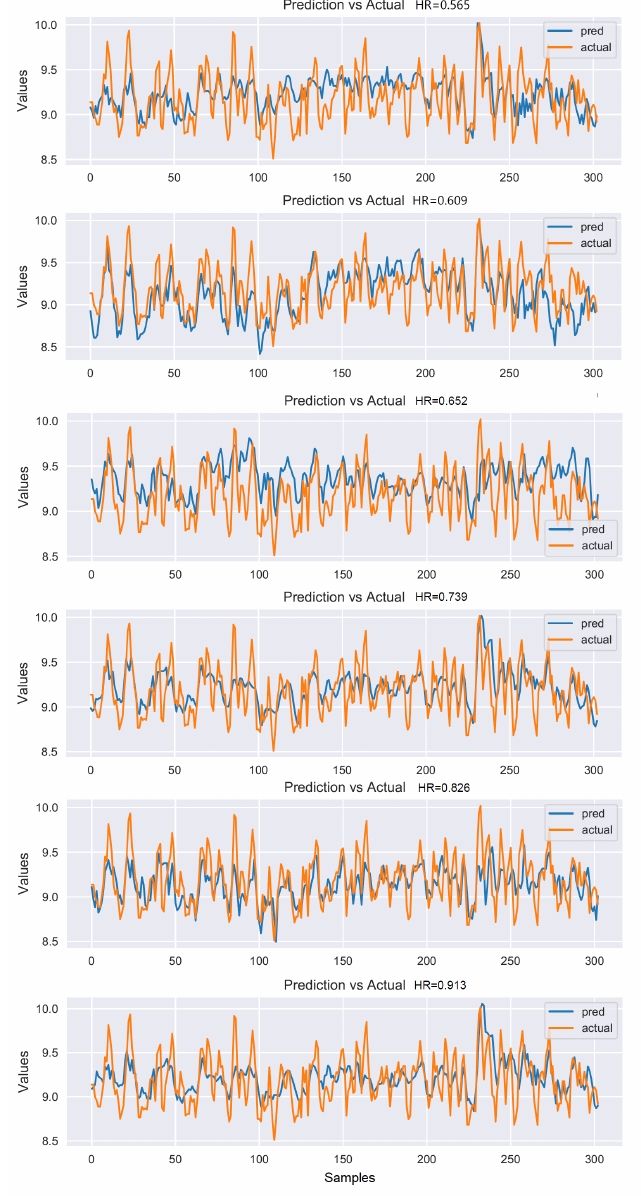
Figure 14. Single experiment results of each